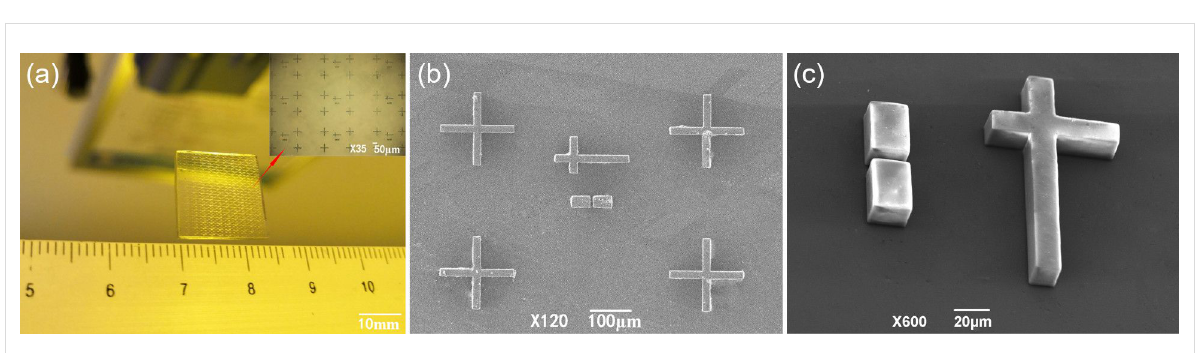
Figure 3: Surface morphology of the PDMS/SiO 2 composite template. (a) Physical appearance of the PDMS/SiO 2 composite template. (b) Microstruc- ture of the PDMS/SiO 2 composite template. (c) Cross-sectional microstructure of the PDMS/SiO 2 composite template.